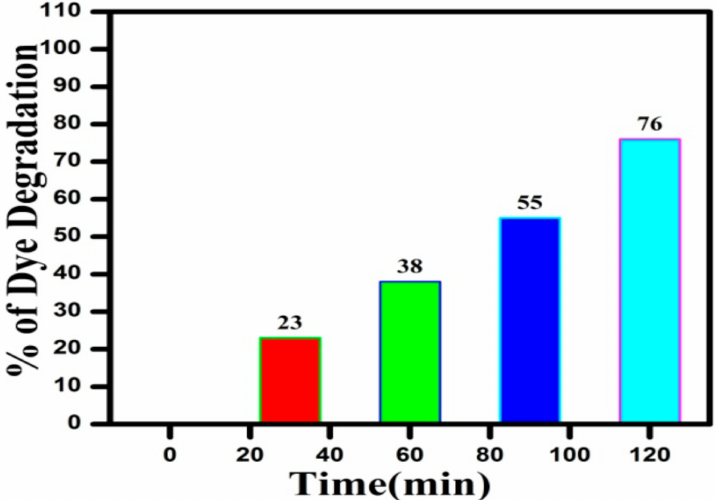
Figure 10. Percentage of degradation of FNH nanoparticles of MB dye vs.